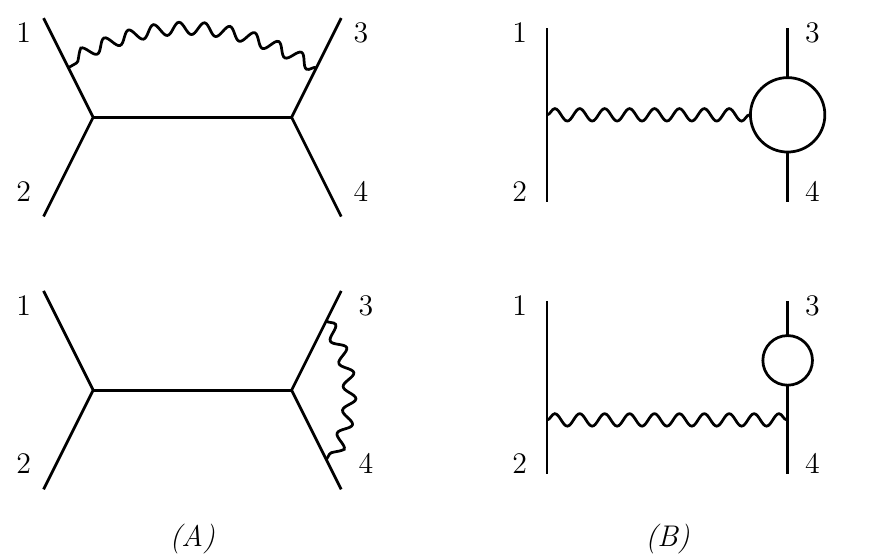
Figure 4 . Some of the Feynman diagrams relevant for section 4.1, with continuous lines for particles with | h | = 0 , 1 / 2 , 1 and wavy lines for gravitons. Diagrams of class (A) on the left and (B) on the right respectively remain connected and get disconnected when the unique graviton propagator is removed. Most of class (B) diagrams, with well understood exceptions in the scalar sector, cancel among themselves as a consequence of the conservation of the energy momentum tensor T µν . This is discussed in appendix